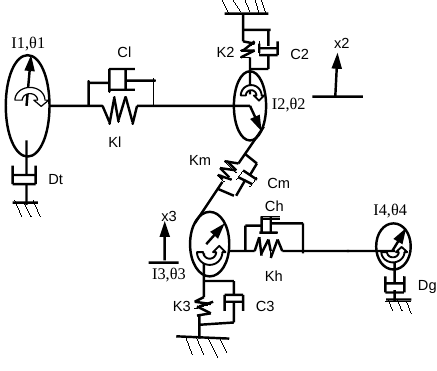
Figure 2. Model of